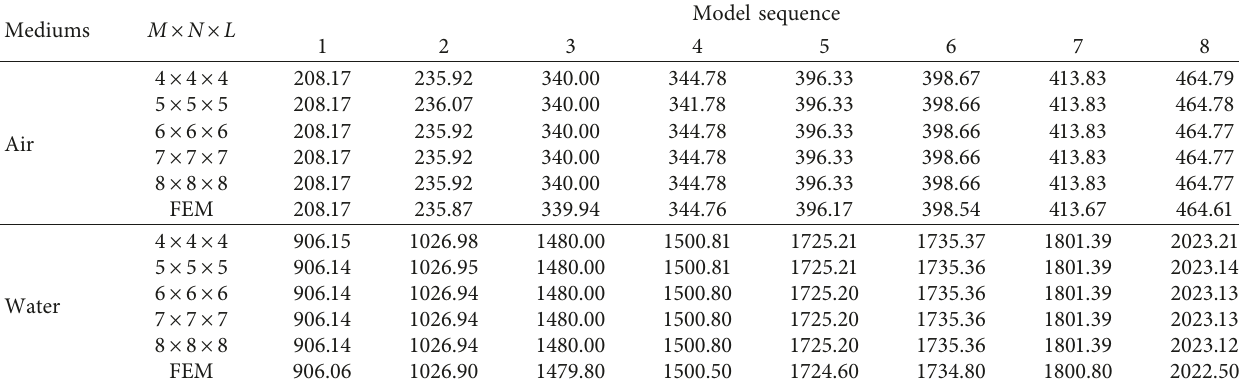
Table 2: The convergence analysis of the first eight natural frequencies (Hz) of the quadrangular prism acoustic cavity. Mediums